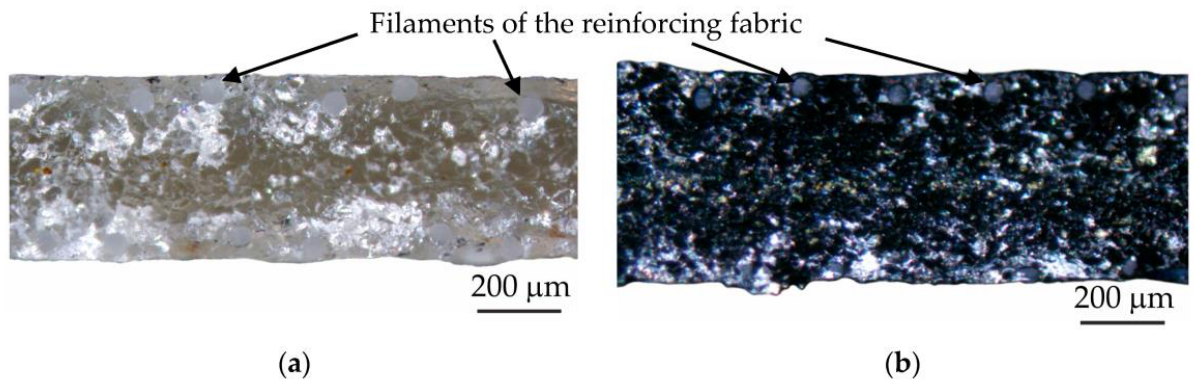
Figure 1. Optical images of the cross-section of the ( a ) pristine MA-41 membrane and ( b ) PPy-modified MA-41 mod membrane in the swollen state.